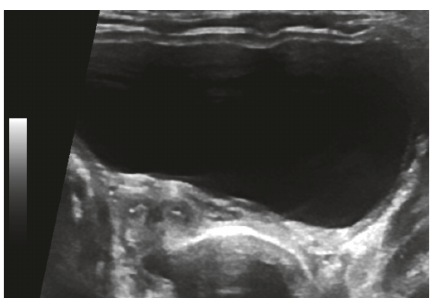
Figure 4: Neonatal bicornuate uterus 1 week